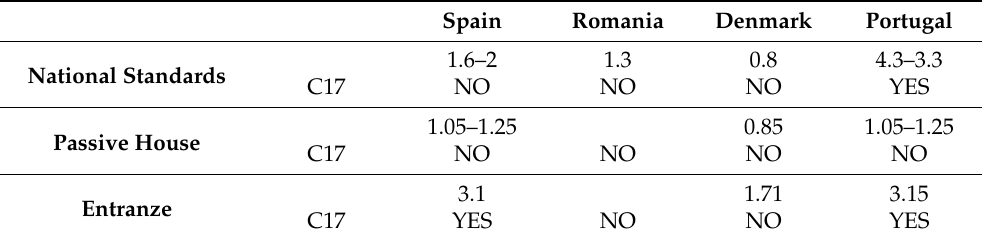
Table 12. Thermal transmittance in windows (W/m 2 K) comparative.